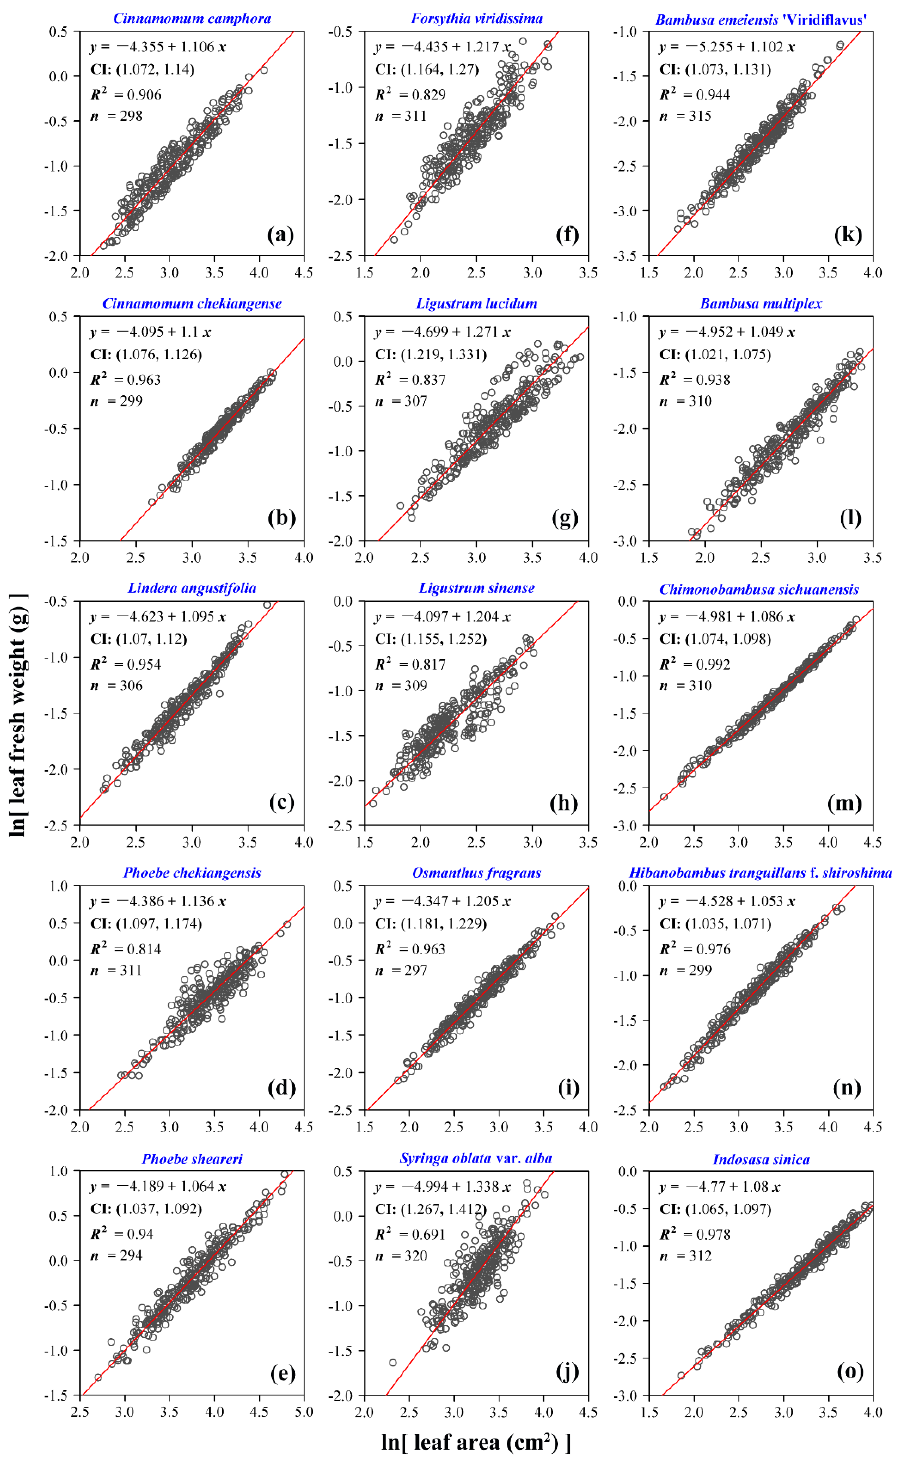
Figure 5. Scaling relationship of leaf fresh weight to leaf area at individual species level. Panels ( a – e ) belong to Lauraceae, panels ( f – j ) belong to Oleaceae, and panels ( k – o ) belong to Bambusoideae. In each panel, the open circles represent the observations, and the red straight line represents the reduced major axis regression line. Furthermore, y represents the natural logarithm of leaf fresh weight in g, x represents the natural logarithm of leaf area in cm 2 , CI represents the 95% confidence interval of the slope, R 2 is the coefficient of determination used to measure the goodness of fit, and n represents the number of leaves sampled.